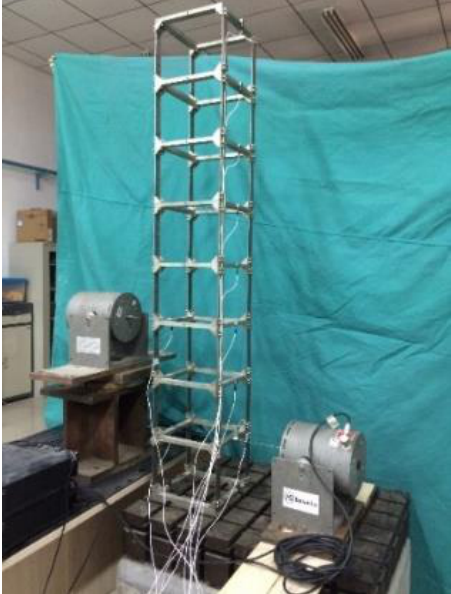
Figure 4. Experimental setup.